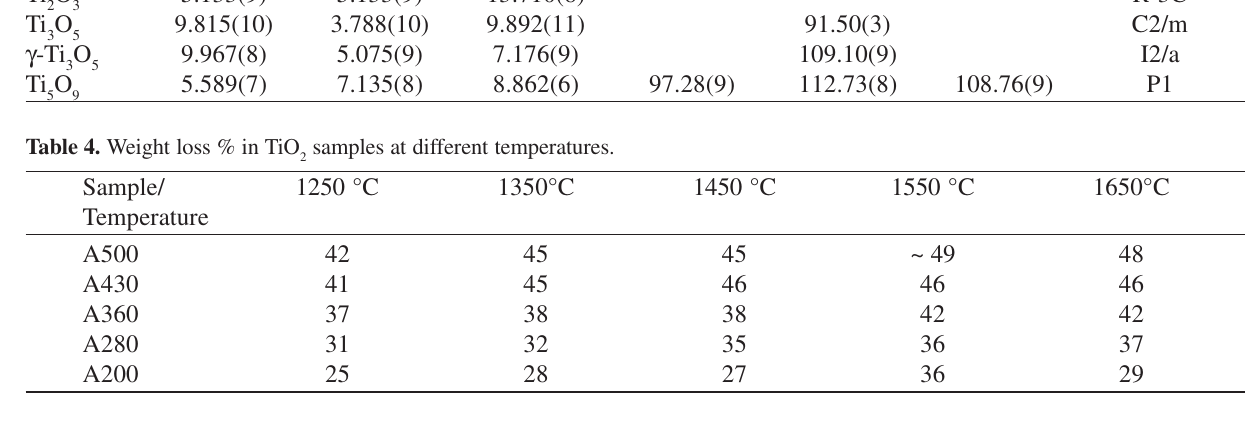
Table 5 . Unit-cell parameter a